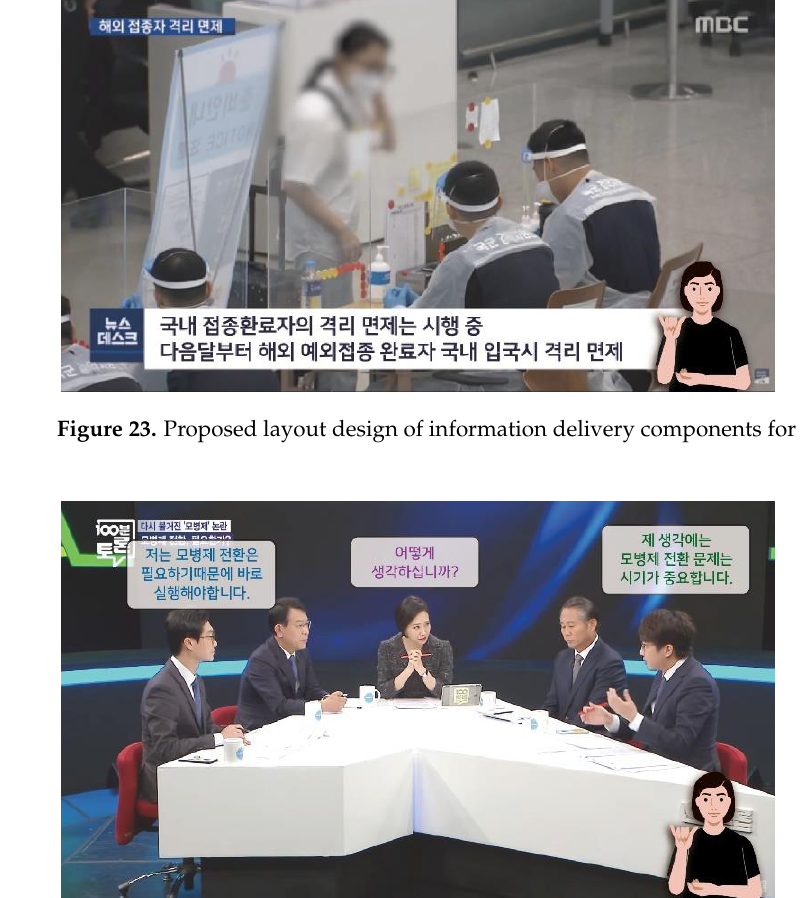
Figure 23. Proposed layout design of information delivery components for news type broadcasts.